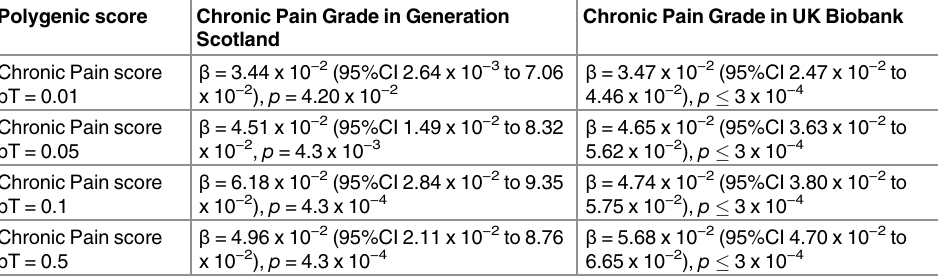
Table 1. The association between Pfizer-23andMe – derived polygenic profiles scores for chronic pain and chronic pain in GS:SFHS and UK Biobank.